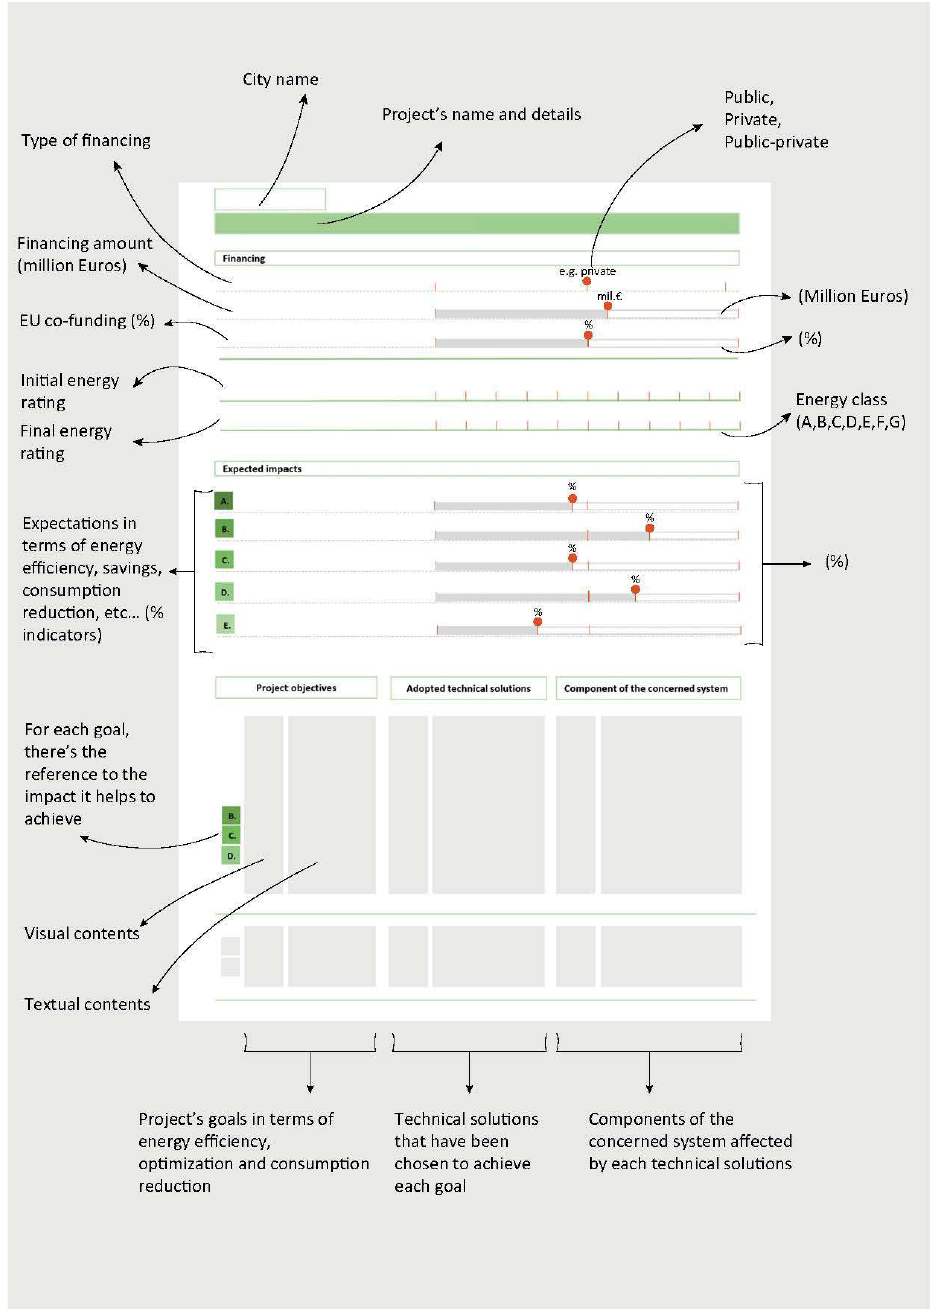
Figure 2. An example of a case-study project intervention sheet, the technological solutions.